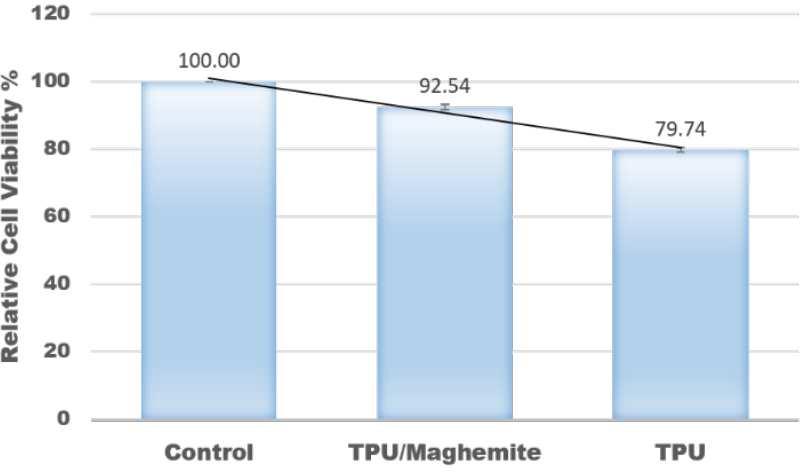
Figure 8. Relative values of cell viability with different composites of materials.